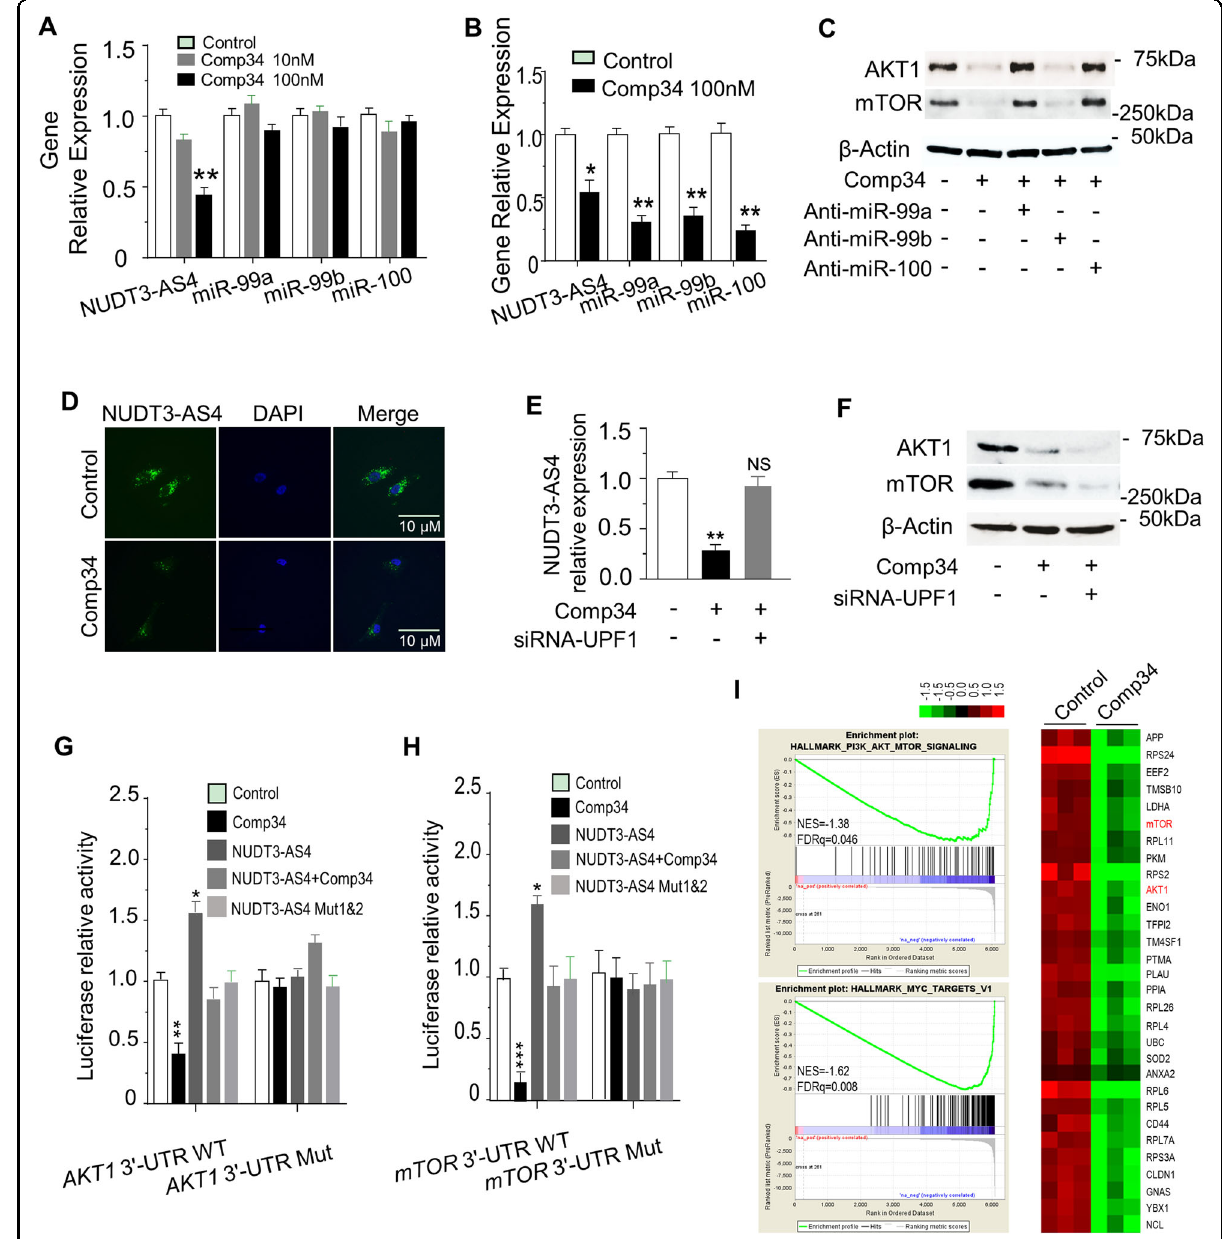
Fig. 5 Comp34 regulates NUDT3-AS4/miR-99s/AKT/mTOR axis. a Comp34 decreases NUDT3-AS4, but not miR-99s expression. Quantitative RT- PCR and RNA fi sh ( d ) assays were performed to measure NUDT3-AS4 and miR-99s level. ** P < 0.01 versus control. b Comp34 dissociates miR-99s from NUDT3-AS4 MS2-RIP complex. MDA-MB-231 cells were transiently transfected with GST-fused MS2 binding protein (GST-MS2BP) together with pTAG2B-MS2-12XH19 (in which NUDT3-AS4 was tagged with MS2-RNA hairpins). Endogenous miR-99s associated with NUDT3-AS4 was detected by MS2-RIP and qRT-PCR. * P < 0.05, ** P < 0.01 versus control. c Anti-miR-99s rescue Comp34-induced decrease in AKT1 and mTOR protein levels. d Localization and abundance analysis of NUDT3-AS4 upon Comp34 treatment at single cell and single molecule resolution. e MDA-MB-231 cells were treated with a control siRNA or with a siRNA targeting UPF1. The relative expression levels of NUDT3-AS4 were determined by RT-qPCR. ** P < 0.01 versus control; NS not signi fi cant. f AKT1 and mTOR protein expression levels were analyzed by immunoblot analysis. g Comp34 reduces, and NUDT3-AS4 increases the luciferase activity of AKT1 3 ’ -UTR WT and mTOR 3 ’ -UTR WT ( h ). Dual-luciferase reporter assays were performed to test the effect of Comp34 and NUDT3-AS4 on the AKT1 3 ’ -UTR or mTOR 3 ’ -UTR using the reporter gene constructs. Data are presented as relative luciferase activity of Renilla activity to Fire fl y luciferase luciferase activity ( n = 3). ** P < 0.01, *** P < 0.001 versus control. i GSEA plot of enrichment in “ mTORC1_SIGNALING ” , “ MYC_TARGETS_V1 ” signatures in Comp34 treatment group versus control group ( n =